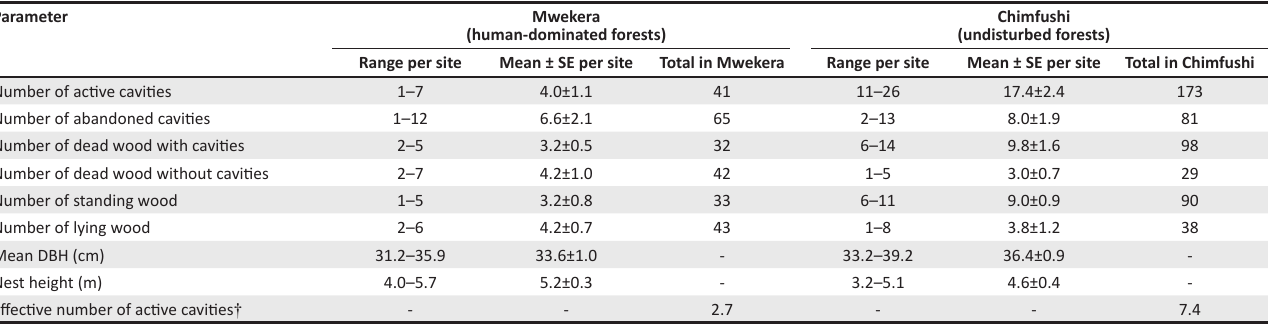
TABLE 2: Parameters explaining occurrence of tree cavities in Mwekera National Forests No. 6 and the Chimfushi Wildlife Orphanage forests, Copperbelt Province, Zambia, 2014. Parameter